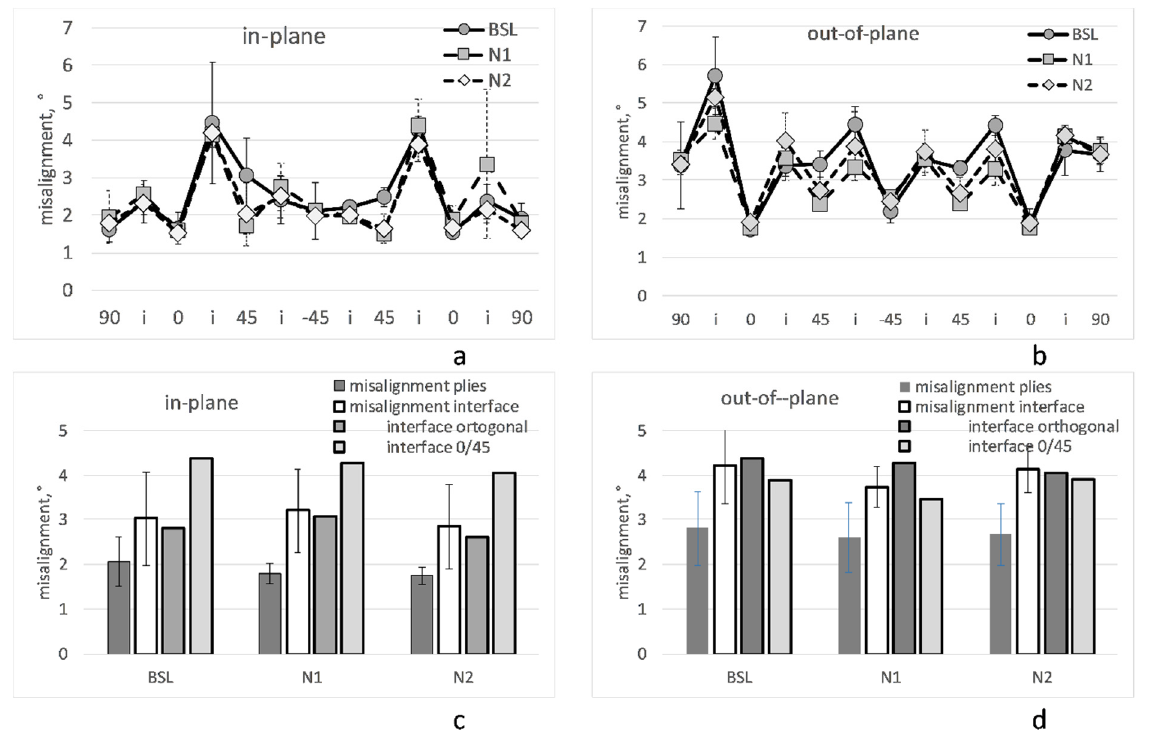
Figure 8. Misalignment of fibers deep inside plies and at the interfaces: ( a , b ) misalignment of in-plane ( a ) and out-of-plane ( b ) angles; horizontal axis enumerates values of the nominal ply orientations and interfaces (“i”) in-between the plies; ( c , d ) average values of in-plane ( c ) and out-of-plane ( d ) misalignment angles inside plies and at the interfaces.